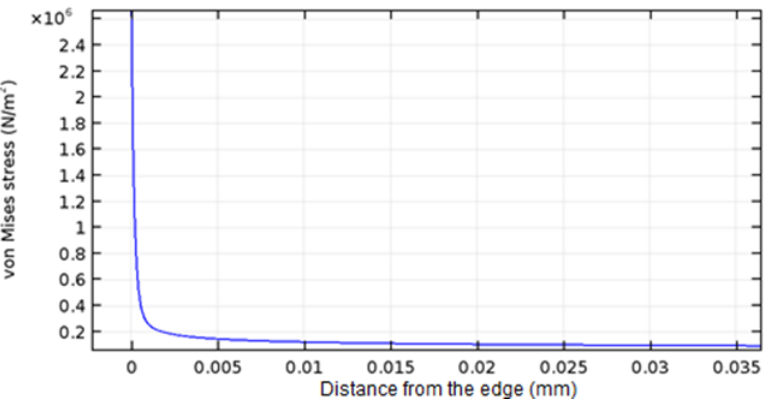
Figure 9. Evolution of the Von Mises Stress when moving away from the edge of the strip.